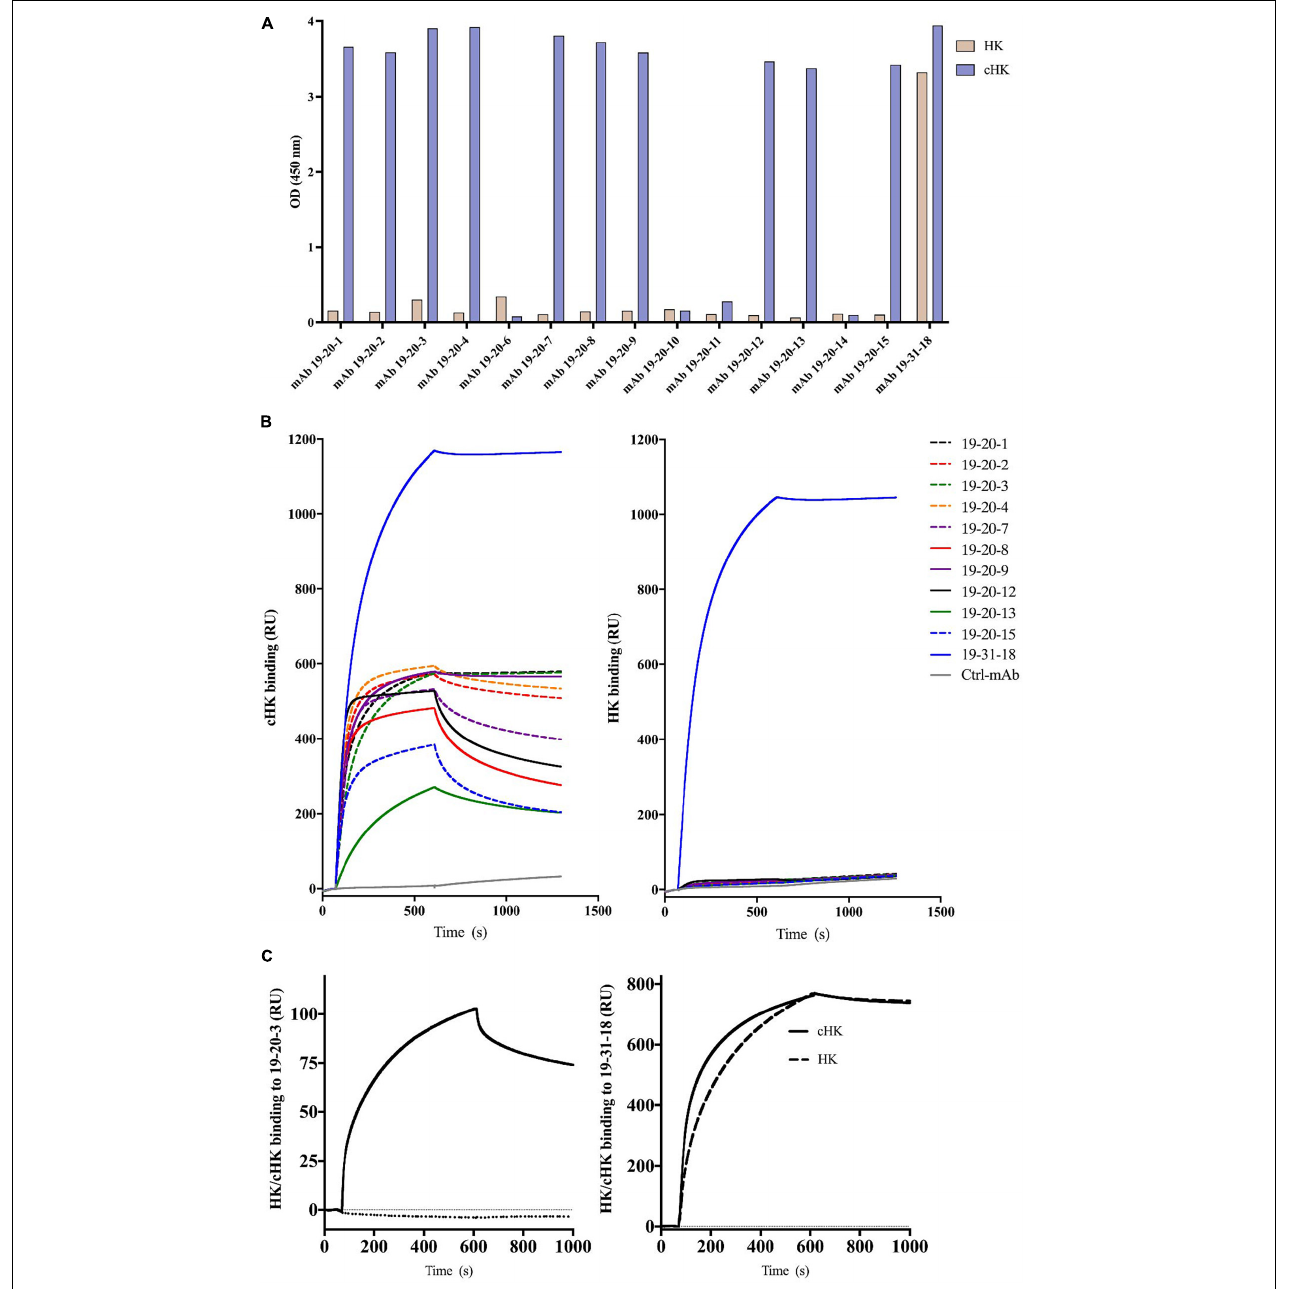
FIGURE 2 | (A) Reactivity of cleaved H-kininogen (cHK) specific monoclonal antibodies (mAbs). ELISA analysis of the specificity of cHK mAbs toward cHK and HK: Microtiter plates were coated with 0.5 µ g/mL purified HK or purified cHK. The mAb 19-31-18 reacting with both HK and cHK was used as a positive control. Two µ g/mL of mAbs were added to the wells. Reactivity levels are given as optical density (OD) at 450 nm. (B) Surface plasmon resonance (SPR) analysis of binding of mAbs (5 µ g/mL) to immobilized cHK and HK (35 pmol/mm 2 ). Murine mAb against diphtheria toxoid was used as control (Ctrl-mAb). (C) SPR analysis of binding of HK/cHK (both 10 µ g/mL) to immobilized mAbs: Binding of purified HK (dotted line) and cHK (solid line) to immobilized mAb 19-20-3 (left) and mAb 19-31-18 (right) (12 fmol of protein/mm 2 ) was analyzed.